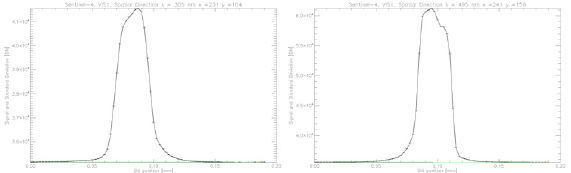
Figure 11. Signal distribution over a pixel ( 305 nm left, 495 nm right). Green line is a zero-point correction the first zero of the sinc